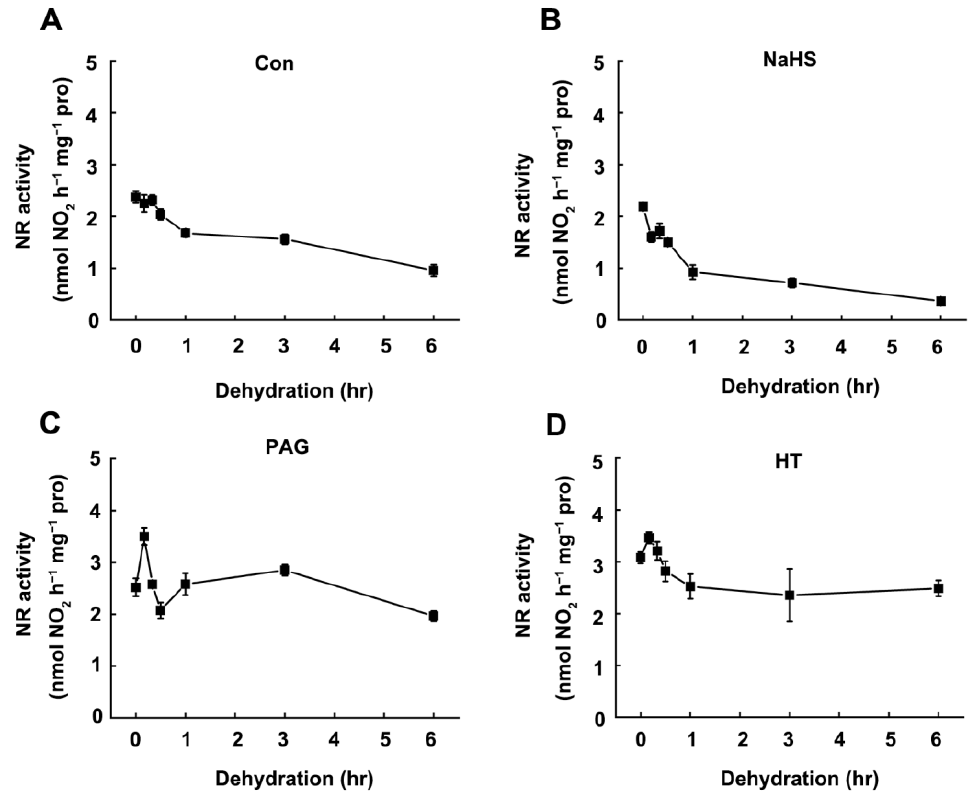
Figure 5. Regulation of NR activity by H 2 S. The 14-day-old rice seedlings cultured under normal conditions ( A ) or retreated with NaHS (100 uM, B ), PAG (1 mM, C ), or HT (1 mM D ). For the dehydration time-course experiment, Leaf blade branches were isolated from cultivated soil and placed in filter paper. The leaves samples were harvested, and the total NR activity was measured at indicated time points. Data are means ± SD ( n = 3).